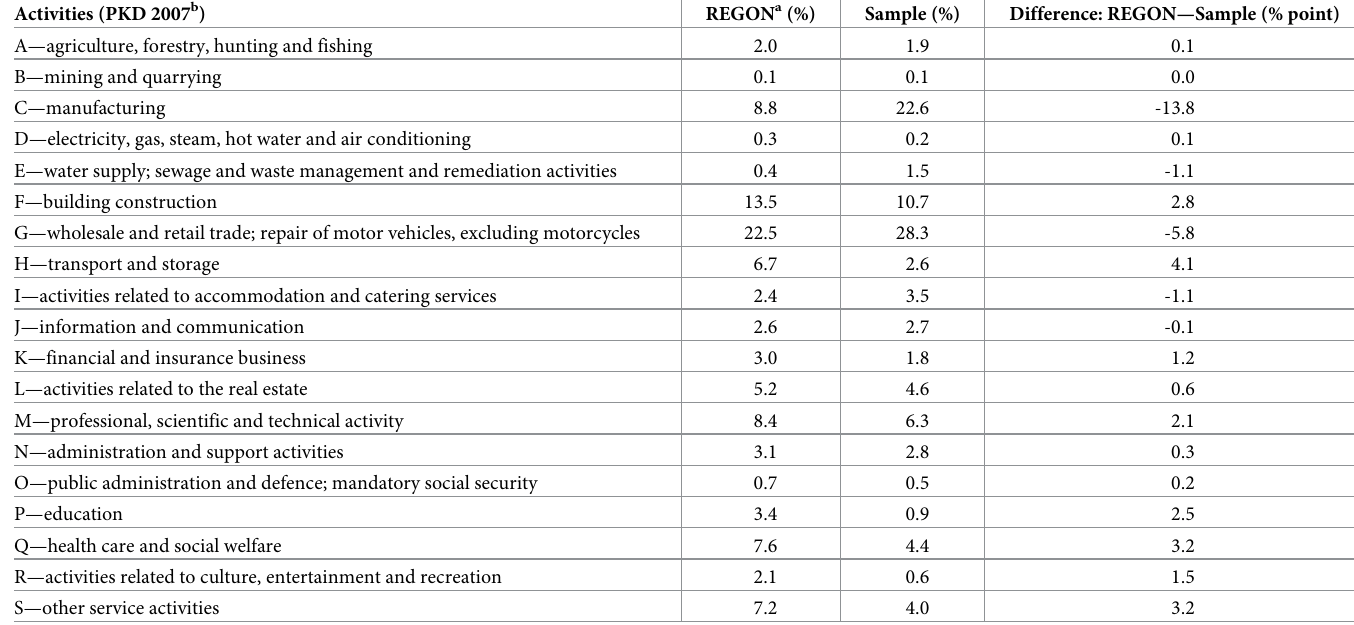
Table 1. Structure of the